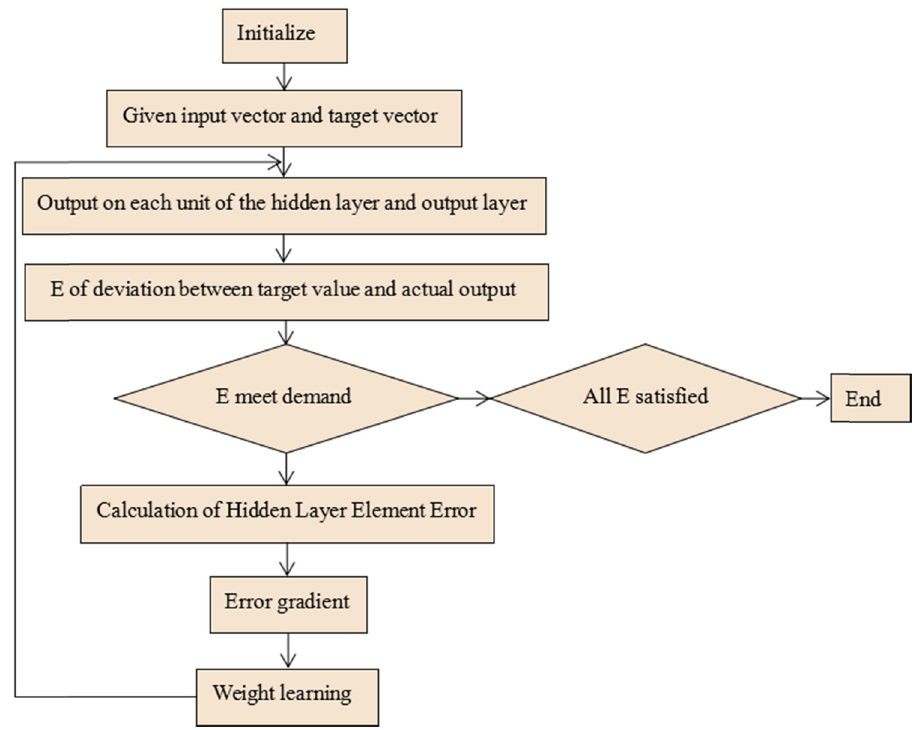
Figure 3: BP algorithm fl